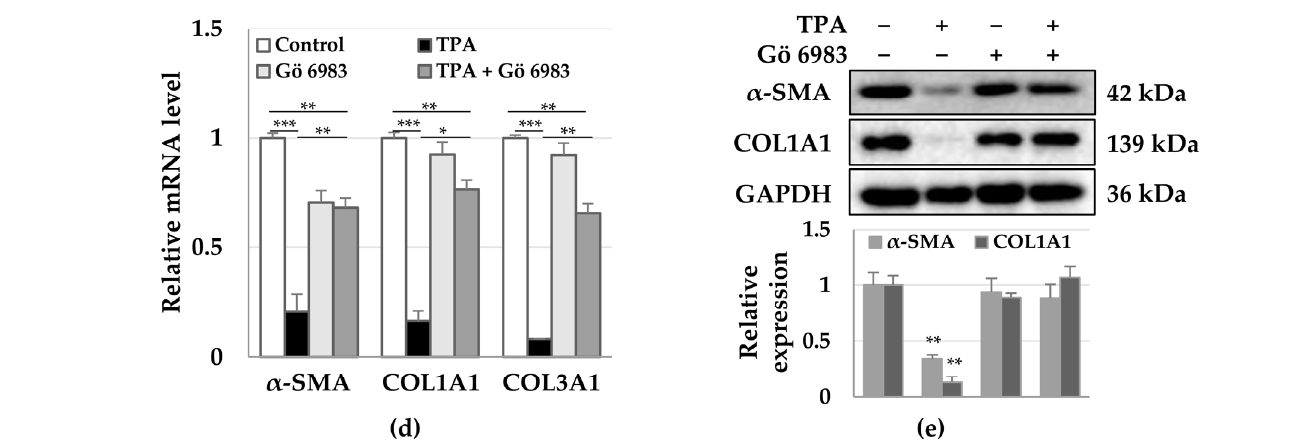
Figure 4. Effects of the pan-PKC inhibitor Gö 6983 on the proliferation and fibrosis of TPA-treated LX-2 cells. LX-2 cells were treated with TPA (10 nM) or Gö 6983 (1 μ M) or both, and then cell viability, cell cycle, and expression of α -SMA were analyzed. ( a ) PKC δ phosphorylation in LX-2 cells treated with TPA, Gö 6983, or both for 12 h. The intensity of pPKC δ was quantified using densitometry with Image J and its relative expression was normalized against that of GAPDH. Data are presented as the mean ± SD of three independent experiments. * p ≤ 0.05 and ** p ≤ 0.01. ( b ) LX-2 cell viability after treatment with TPA or Gö 6983 or both for 48 h. Data are presented as the mean ± SD of four independent experiments. ** p ≤ 0.01. ( c ) Cell cycles of LX-2 cells treated with TPA or Gö 6983 or both. The percentage of cells was analyzed using 2 × 10 4 cells treated with TPA or Gö 6983 or both for 12 h. Data are presented as the mean ± SD of three independent experiments. ( d ) Expression of α -SMA , COL1A1 , and COL3A1 mRNA in LX-2 cells treated with TPA or Gö 6983 or both for 48 h. All qPCR reactions were performed in triplicates. Expression of GAPDH was used for normalization. The 2 − ( ΔΔ Cq) method was used to calculate relative fold changes in mRNA expression. Data are presented as the mean ± SD of three independent experiments. * p ≤ 0.05, ** p ≤ 0.01, and *** p < 0.001. ( e ) Expression of α -SMA and COL1A1 in LX-2 cells treated with TPA or Gö 6983 or both for 48 h. * p ≤ 0.05, ** p ≤ 0.01, and *** p < 0.001. The intensity of protein expression was quantified using densitometry with Image J and its relative expression was normalized against that of GAPDH. Data are presented as the mean ± SD of three independent experiments. ** p ≤ 0.01.